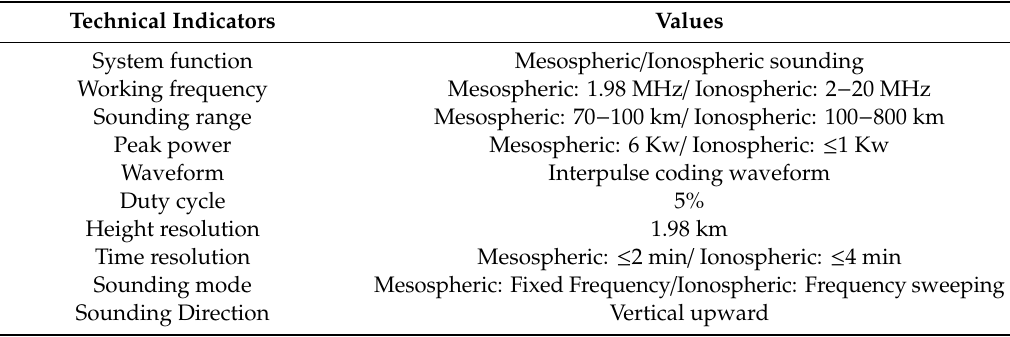
Figure 1. The overall structure of the MAI system, which is mainly divided into three parts: the transmitting channel, multi-channel receiver and receiving antenna array. Table 1. The main technical indicators of MAI system.